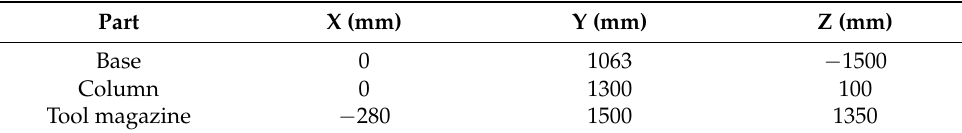
Table 3. Joints setting